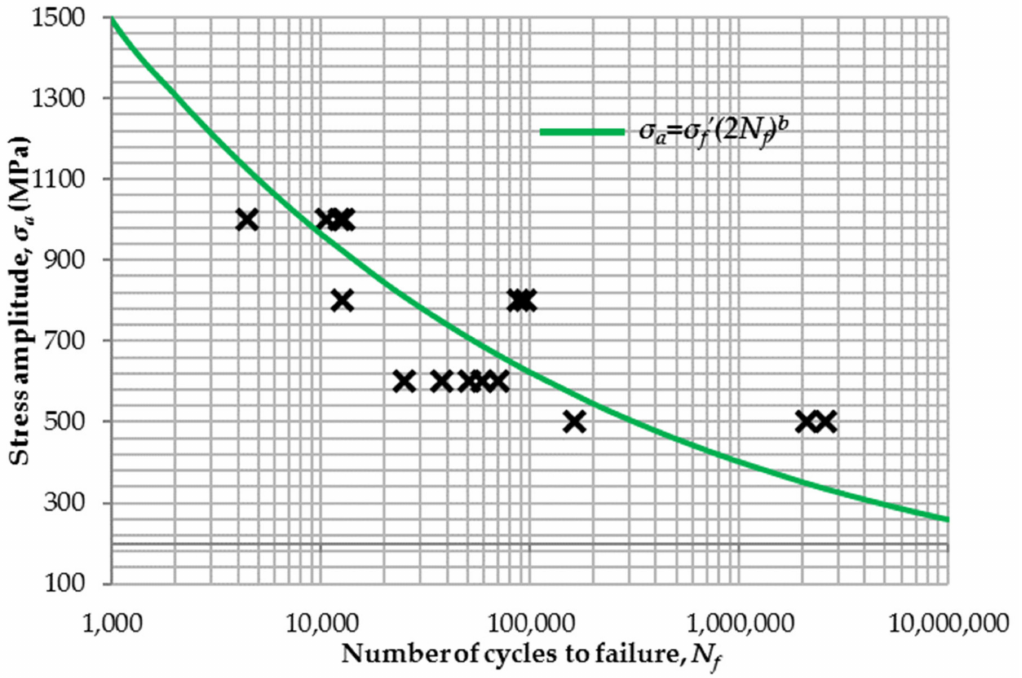
Figure 8. Semi-log S – N curve for uniaxial stress-controlled tests of X37CrMoV5-1 steel